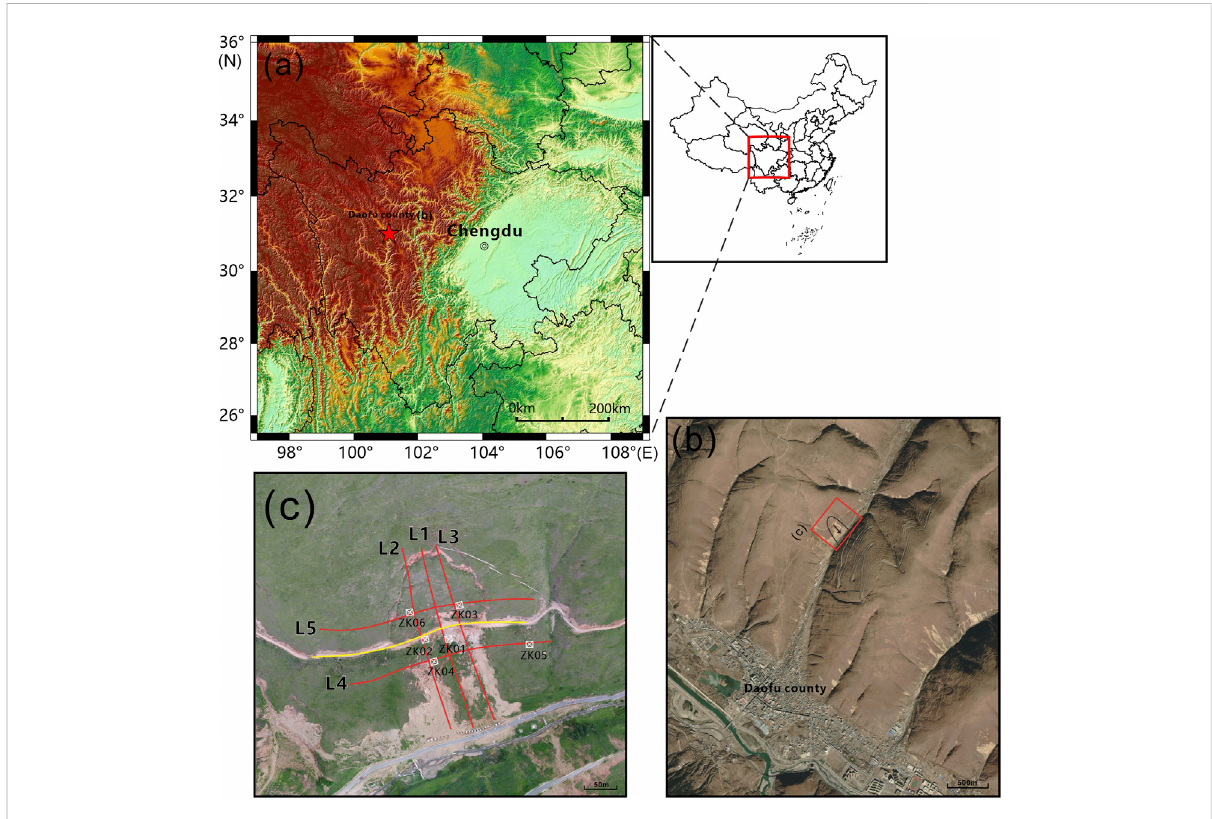
FIGURE 1 (A) MapofChina,LocationofSichuanProvince (B) ElevationtopographicmapofSichuanProvinceandlocationofstudyarea,thered fi vepointed star is the location of the study area (C) Aerial photo of the study area, survey line layout and borehole